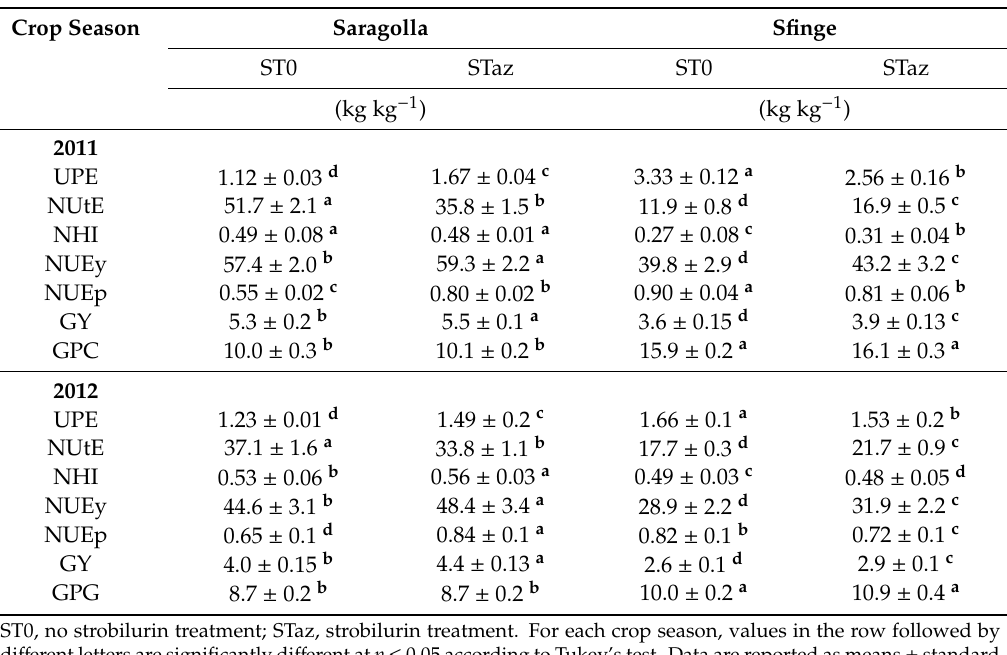
Table 7. E ff ect of the interactions between cultivar and strobilurin treatment in 2011 and 2012 on uptake e ffi ciency (UPE), nitrogen utilization e ffi ciency (NUtE), nitrogen harvest index (NHI), nitrogen use e ffi ciency for yield (NUEy), nitrogen use e ffi ciency for protein (NUEp), grain yield (GY) and grain protein content (GPC).